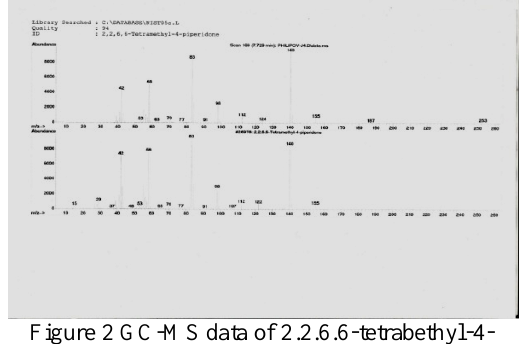
piperidone Table 1. Alkaloids from cultivated plant of P.